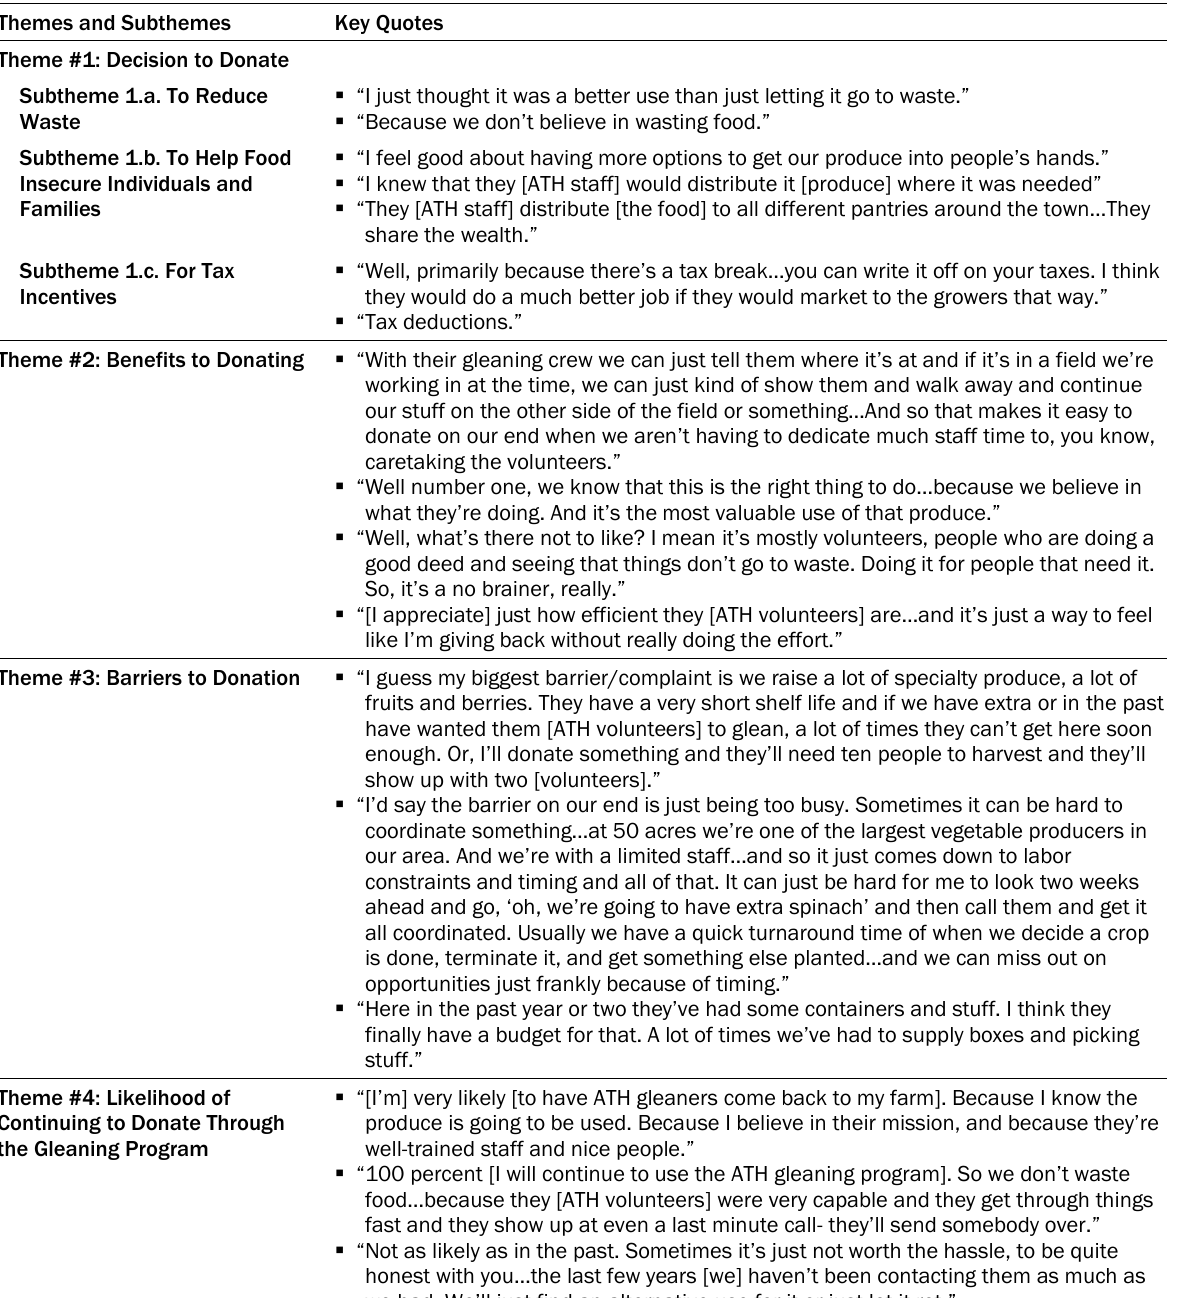
Table 3. Experience with Gleaners: Themes, Subthemes, and Key